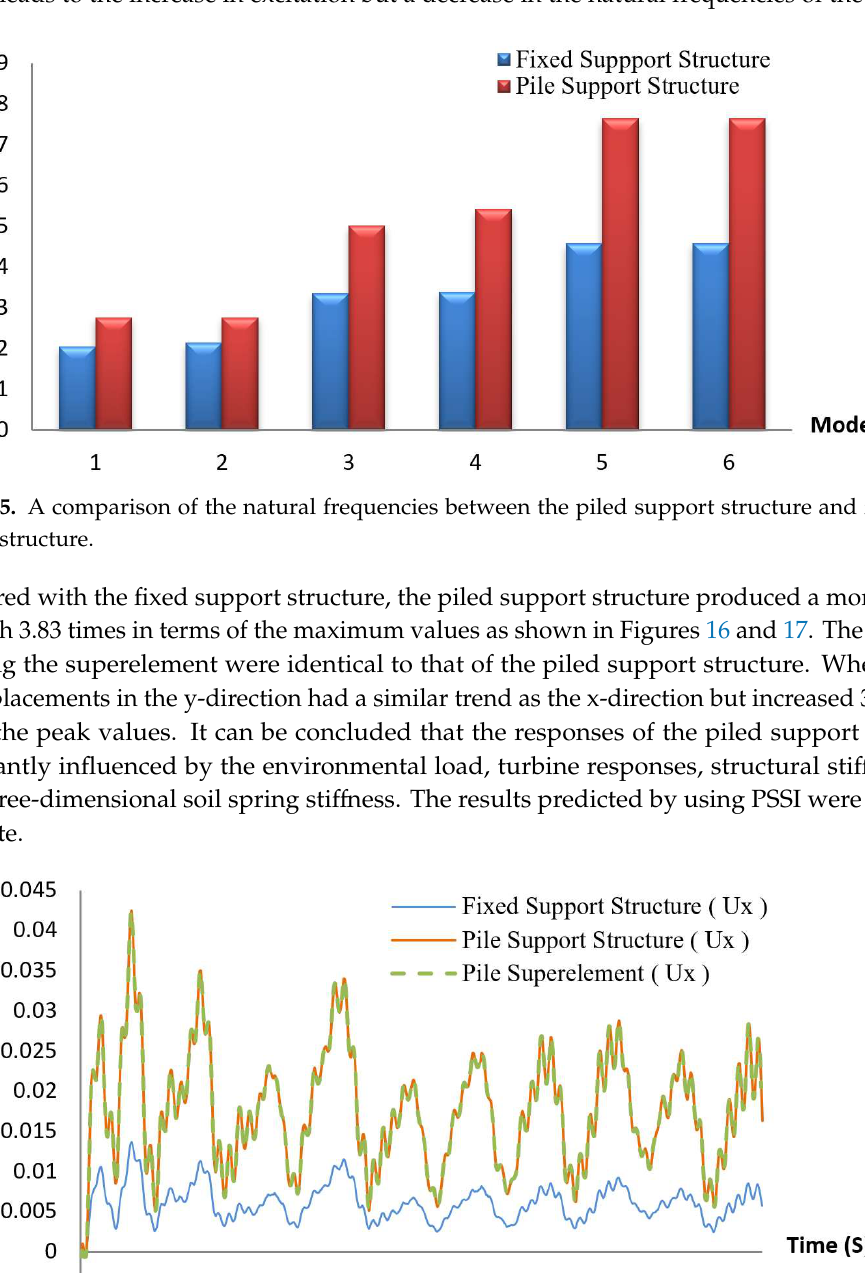
Figure 14. The natural frequencies and mode shape of piled support structure (scaling factor = 25).